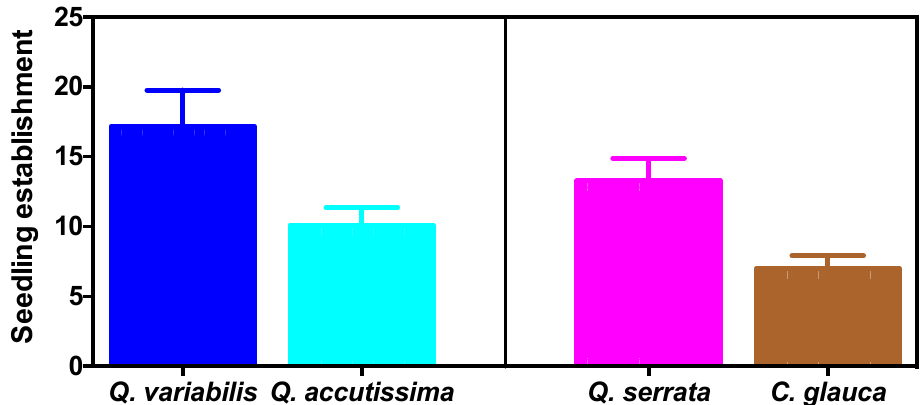
Figure 4. Seedling establishment from artificial caches of Q. variabilis , Q. accutissima , Q. serrata , and C. glauca . Bars sharing different letters indicate statistically significant at p < 0.05 level.